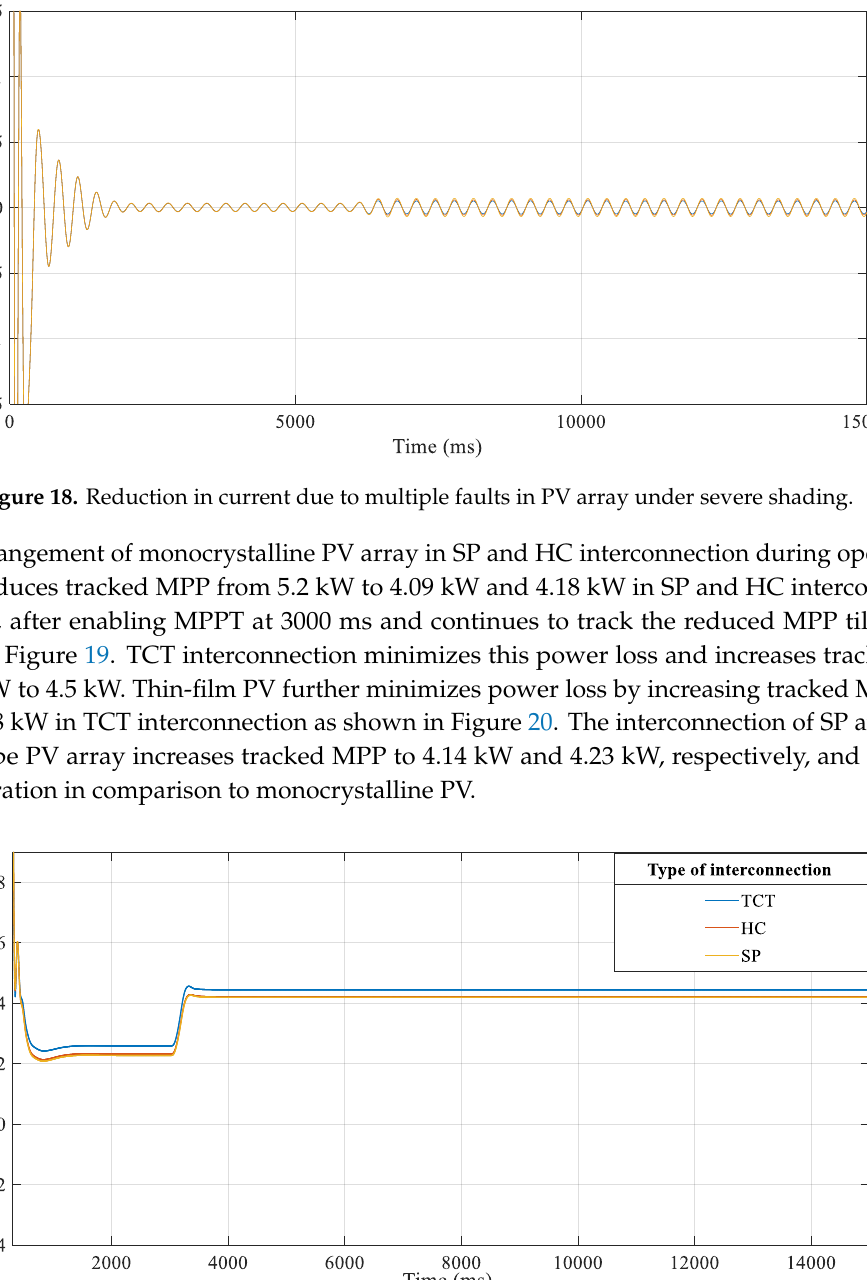
Figure 17. Power of the grid under normal condition.